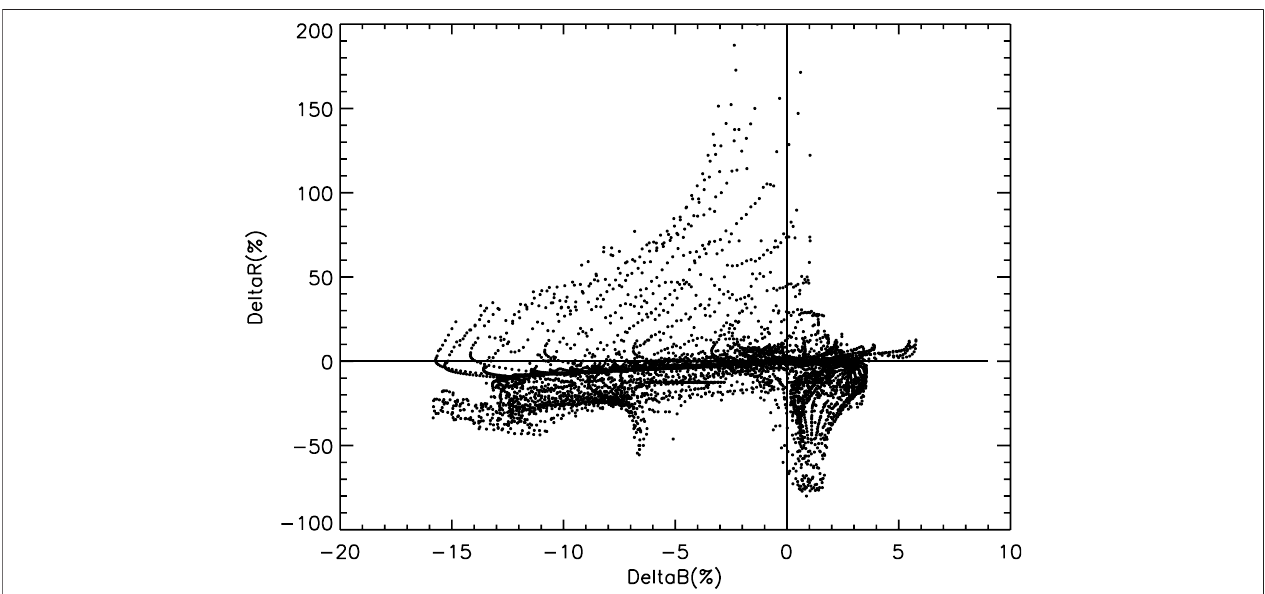
FIGURE 8 | Relationship of the variation of the global rigidities and the global geomagnetic fi eld. For the global grids with the spatial resolution by 1 for latitude and 10 for longitude, nearly 40% of the changes of these two parameters are inconsistent. Also, when the magnetic fi eld becomes intense, 16.5439% of the cutoff rigidities will become smaller, while 23.1737% will become larger. Also when the magnetic fi eld becomes smaller, 11.6943% of the cutoff rigidities will become smaller, while 48.5727% will become larger.